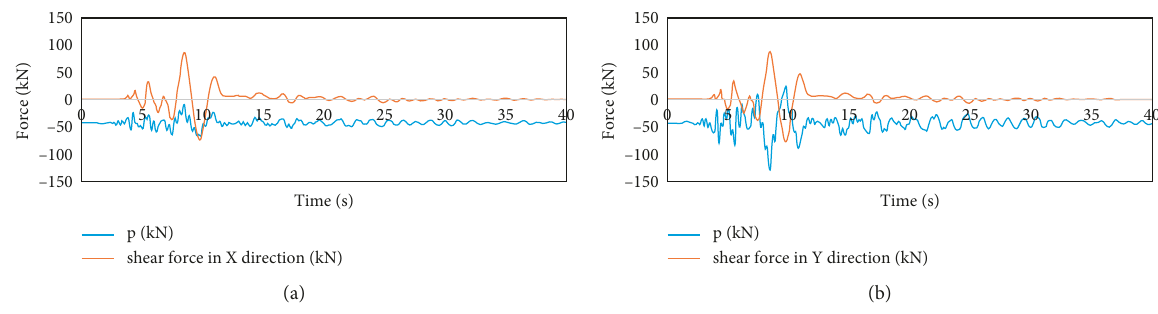
Figure 42: Time course curve of bearing force under N90 seismic wave. (a) X-directional input. (b) Y-directional